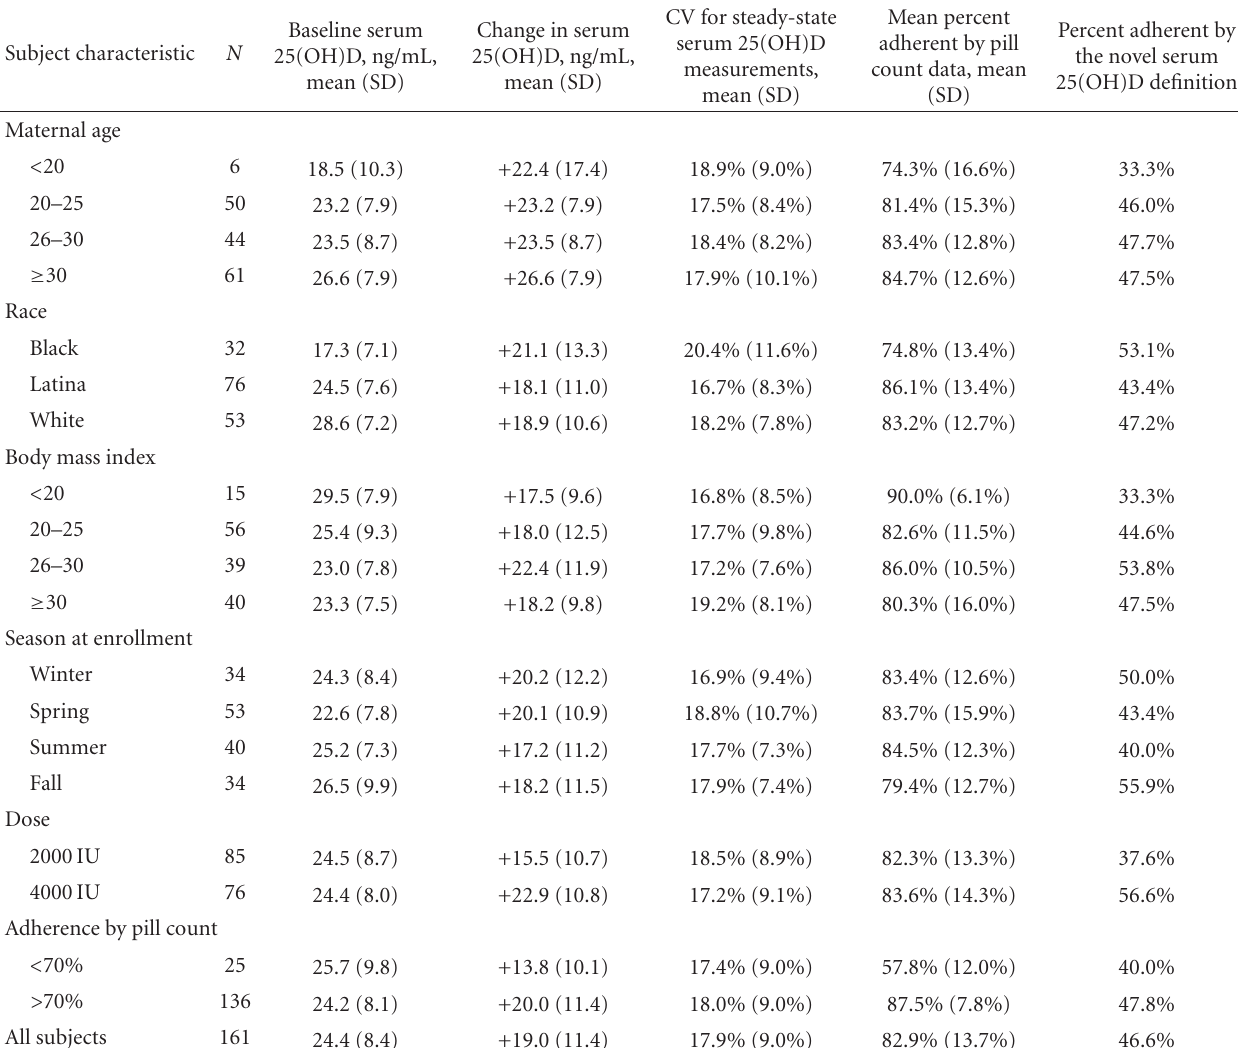
Table 1: Subject characteristics by serum 25(OH)D and adherence